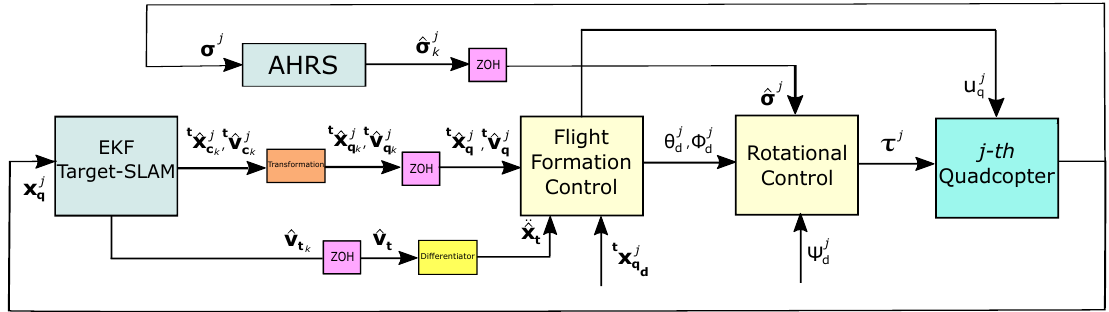
Figure 5. Control scheme